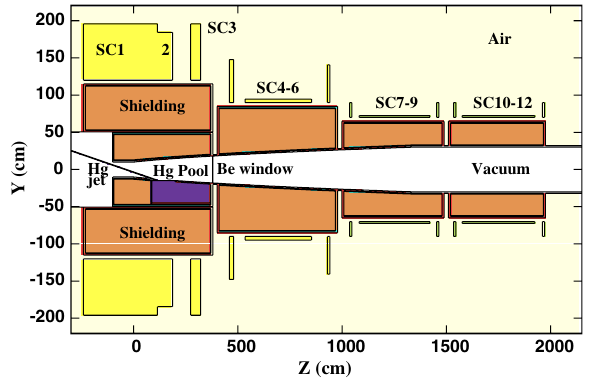
FIG. 4. Schematic of the updated target geometry configura- tion with increased shielding. The superconducting magnets are labeled SC n , where n ¼ 1 to 12.